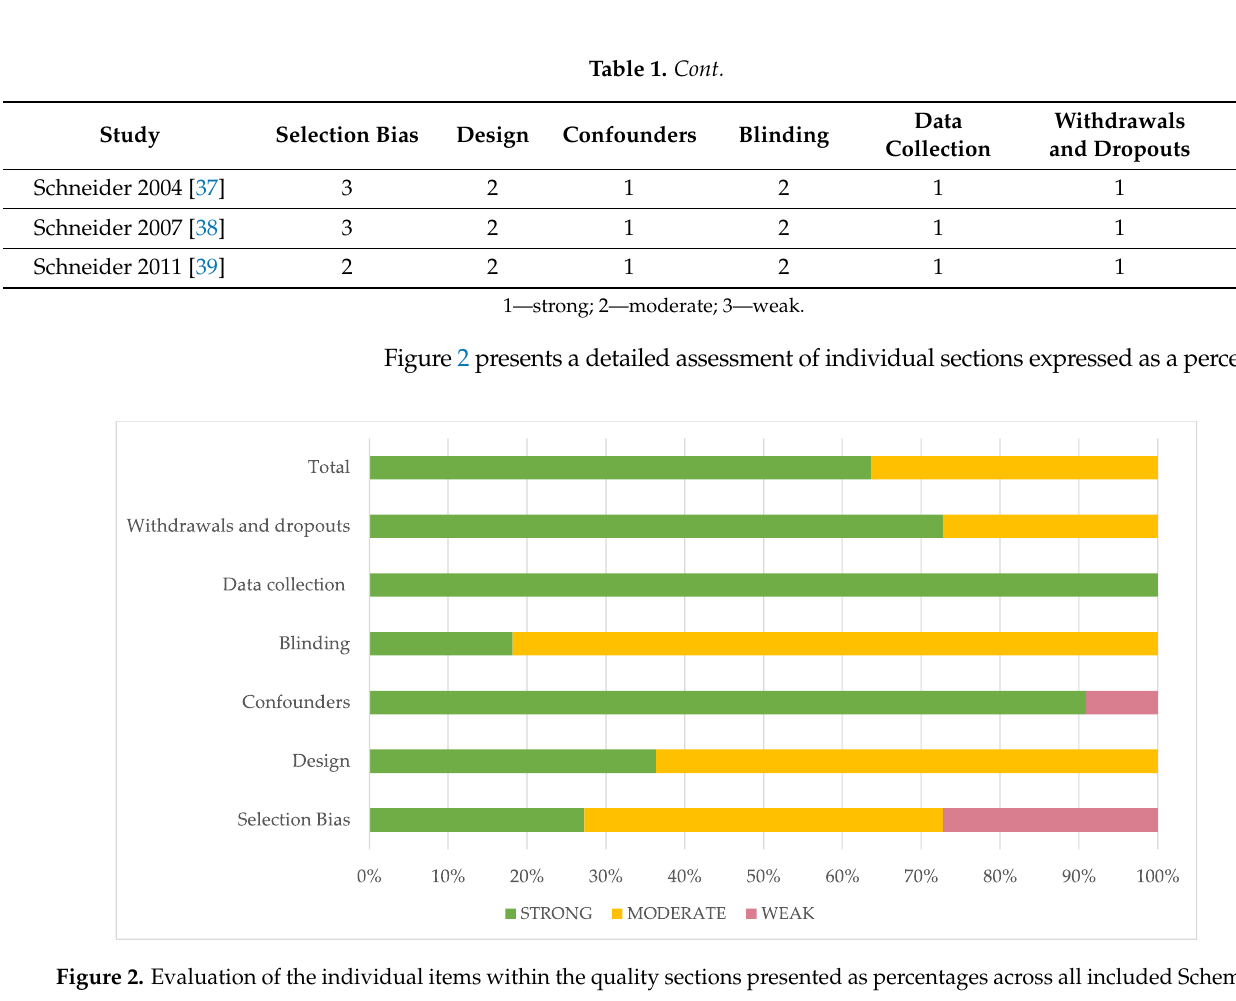
Table 2. Characteristics of the participants of the included